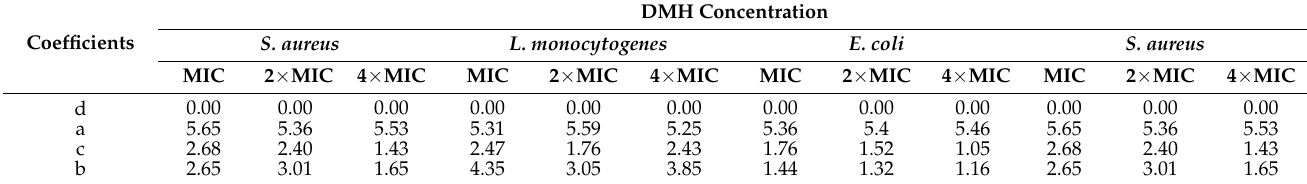
Table 7. Regression coefficients for time-kill kinetics models for DMH-treated samples.